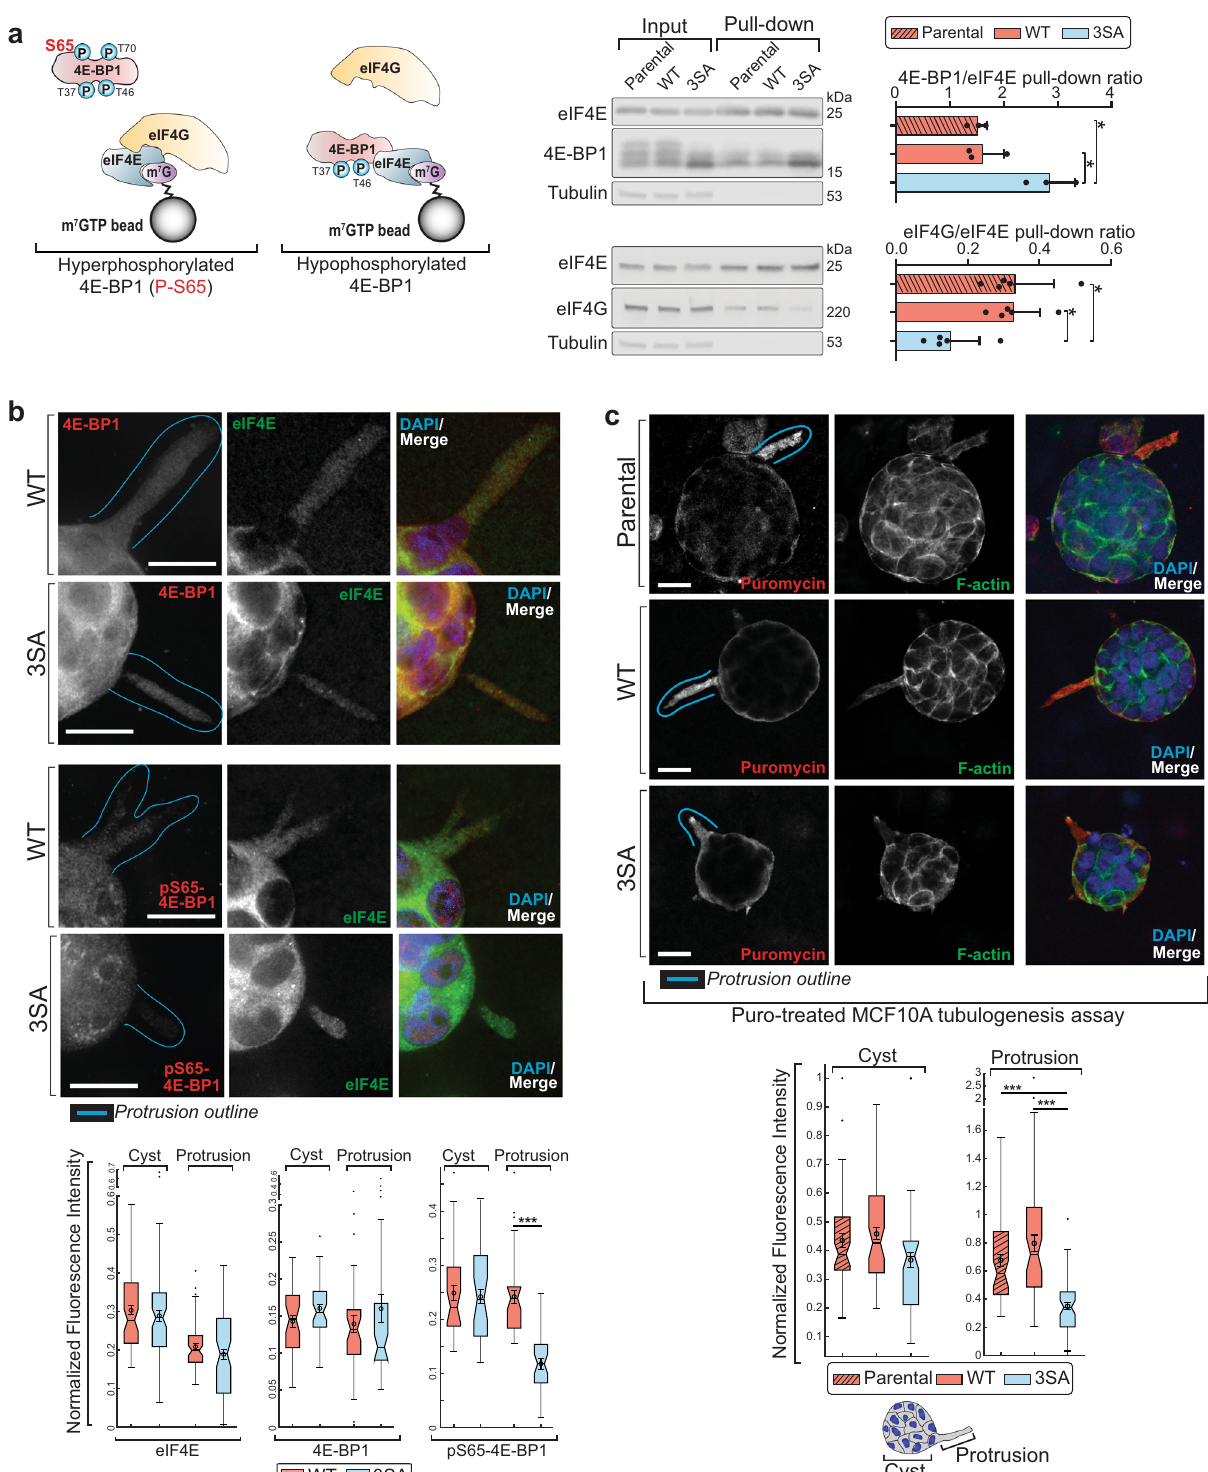
eIF4GeIF4E TubulinHypophosphorylated